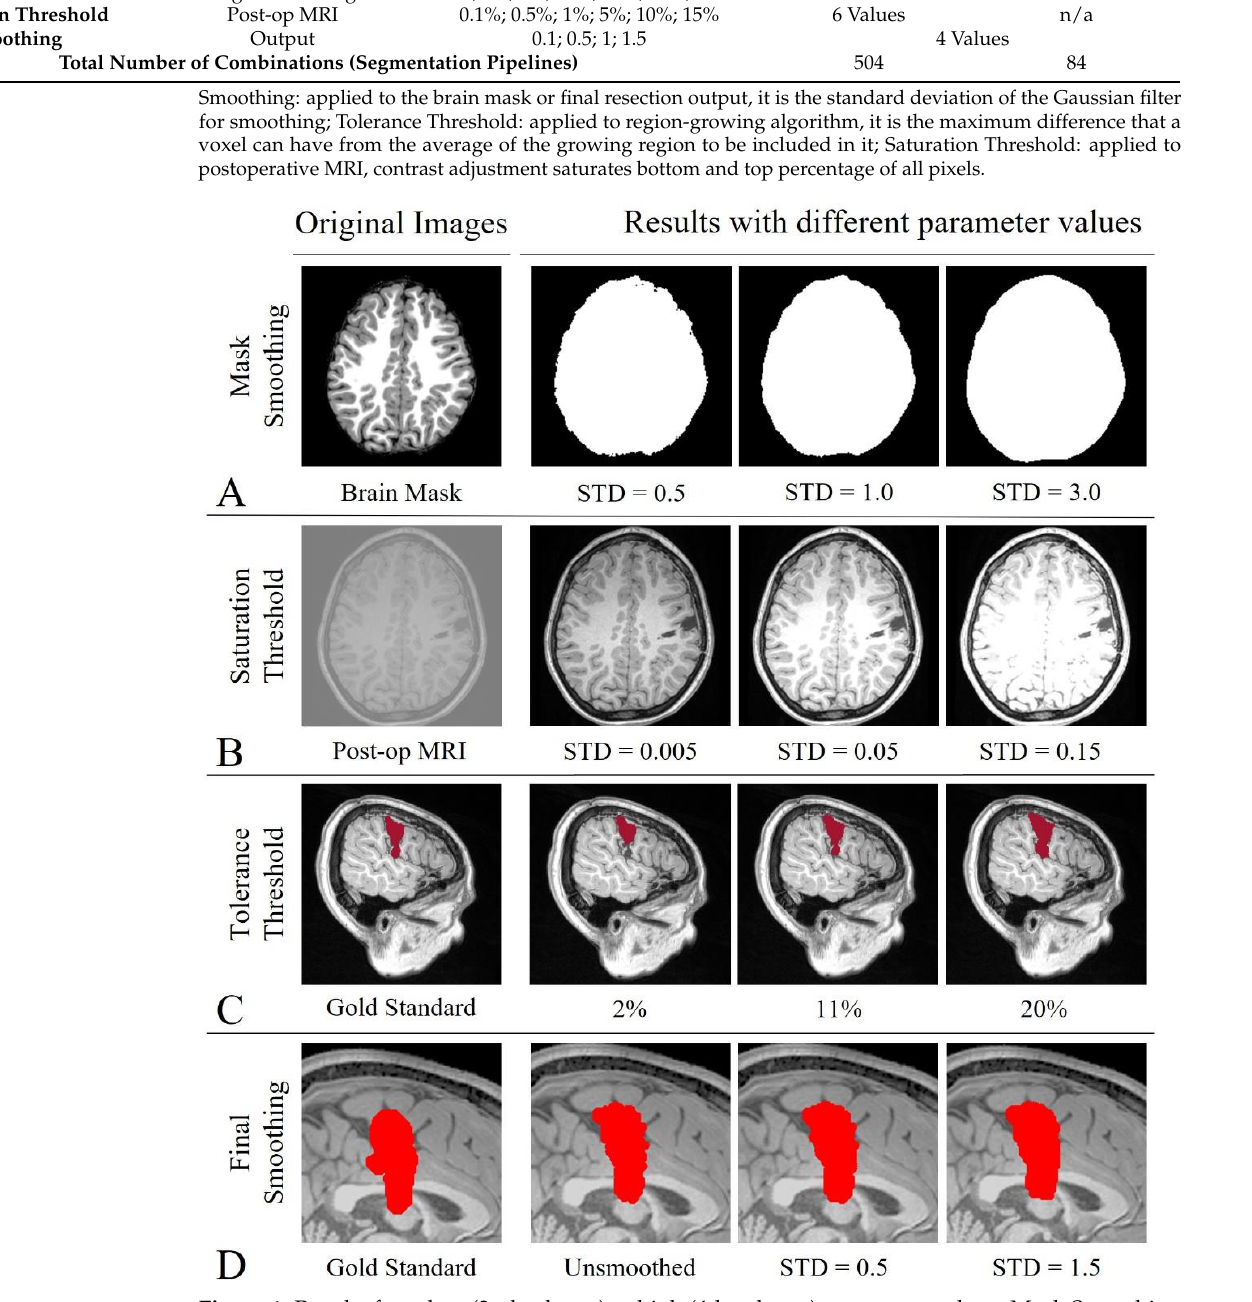
Figure 1. Results from low (2nd column) to high (4th column) parameter values. Mask Smoothing ( A -1st row): original preoperative MRI brain mask (left) and three different binarized smoothed masks (right); Saturation Threshold ( B -2nd row): low-contrast original postoperative MRI (left) and three contrast-adjusted images (right); Tolerance Threshold ( C -3rd row): manual traced resection (left) and three examples of resections obtained with increasing tolerance value (right); and Final Smoothing ( D -4th row): manual traced resection (left) and three different values of smooth- ing.